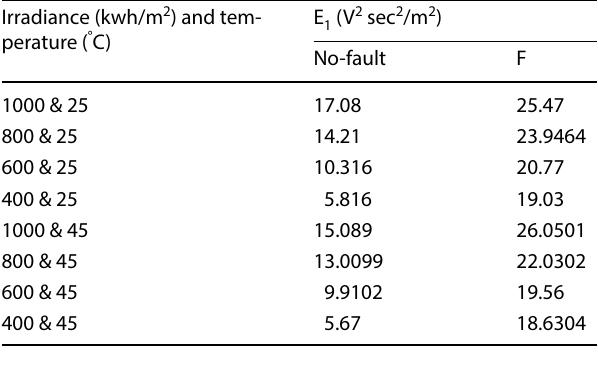
Table 4 Energy levels for various open circuit fault Irradiance (kwh/m 2 ) and